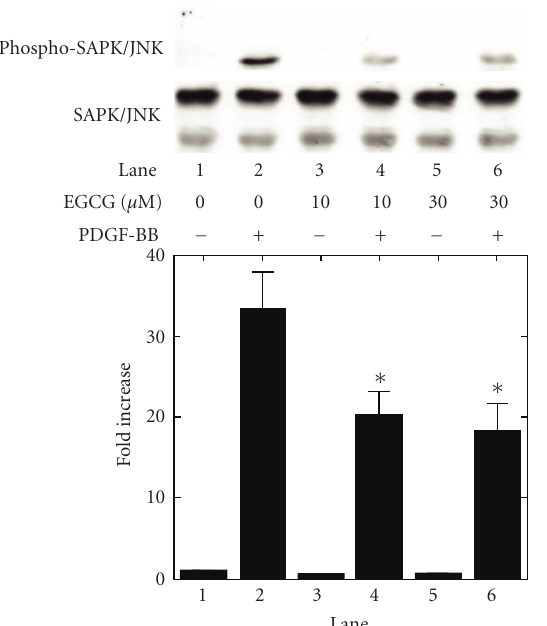
Figure 4: E ff ect of EGCG on the phosphorylation of SAPK/JNK induced by PDGF-BB in MC3T3-E1 cells. The cultured cells were pretreated with the indicated doses of EGCG or vehicle for 60 minutes, and then stimulated by 50 ng/mL PDGF-BB or vehicle for 3 minutes. The extracts of cells were subjected to SDS-PAGE with subsequent Western blotting analysis with antibodies against phospho-specific SAPK/JNK or SAPK/JNK. The histogram shows quantitative representations of the levels of PDGF-BB-induced phosphorylation obtained from laser densitometric analysis of three independent experiments. Each value represents the mean ± SEM of triplicate determinations. Similar results were obtained with two additional and di ff erent cell preparations. ∗ P < . 05: compared to the value of PDGF-BB